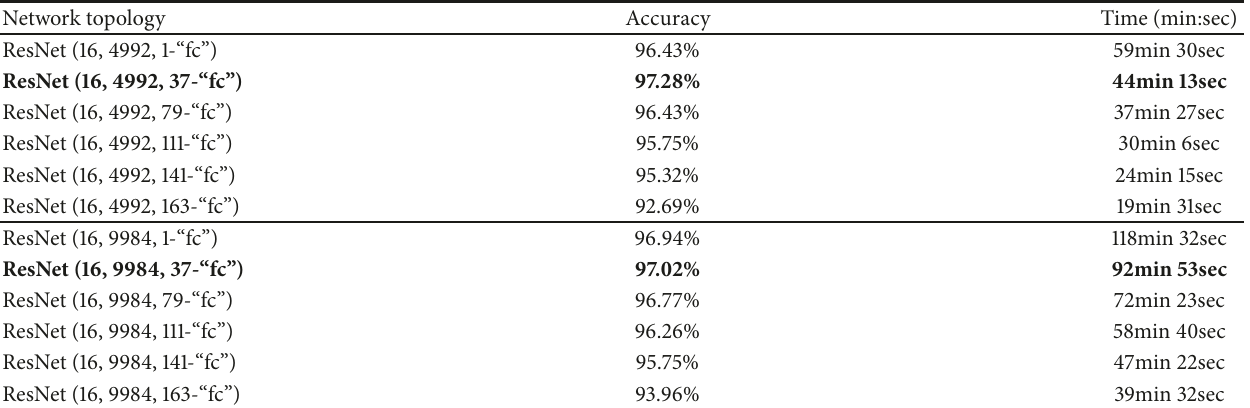
Table 5: Accuracies and training time in different network structures. The values inside parenthesis denote batch size, number of iterations, and training